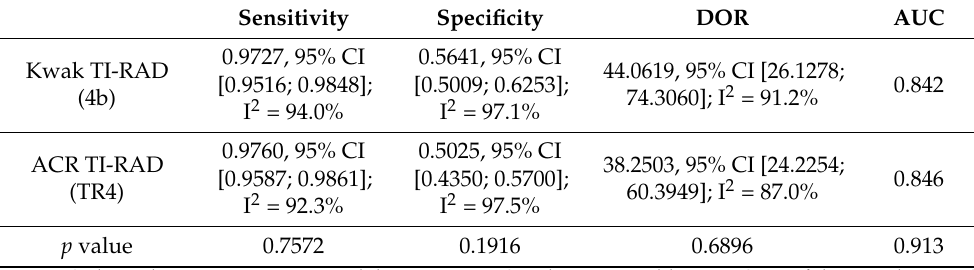
Table 3. Direct comparison of Kwak (4b) and ACR TI-RADS (TR4) categories.